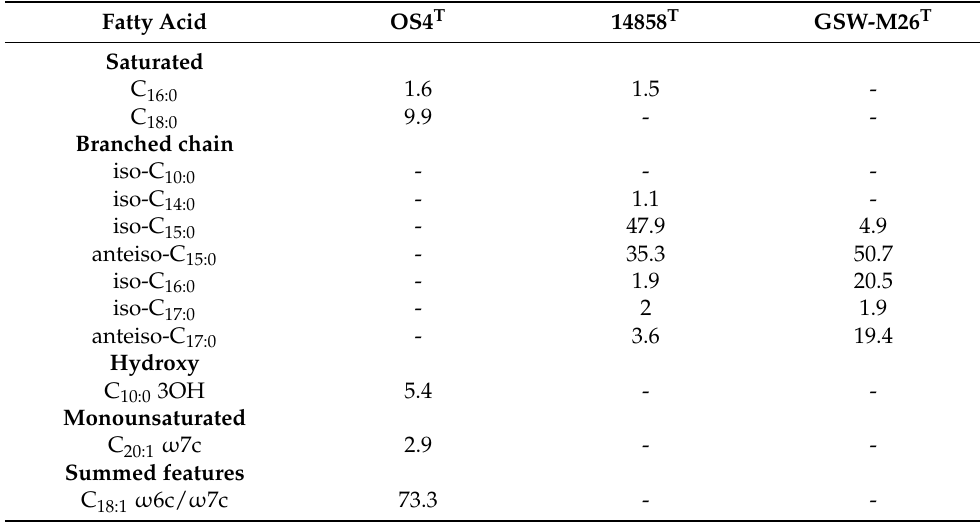
Table 2. Cellular fatty acid contents (%) of strain OS4 T and the related Jannaschia species.